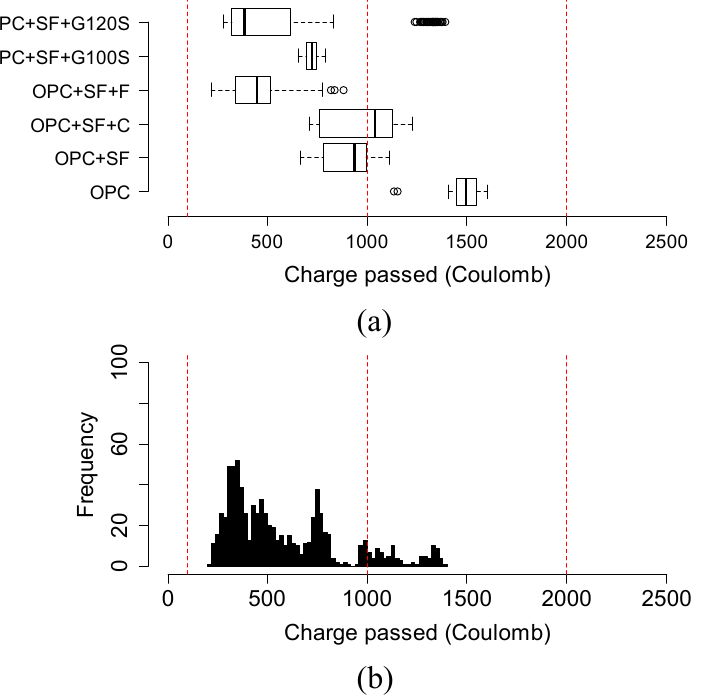
Figure 10. ( a ) Variation and ( b ) distribution of charge passed of Class F fly ash-based mixtures at 91 days. Three vertical red lines in the box plot represent the range of negligible, very low, and low permeability chloride ion permeability class as classified by ASTM C1202 specification.